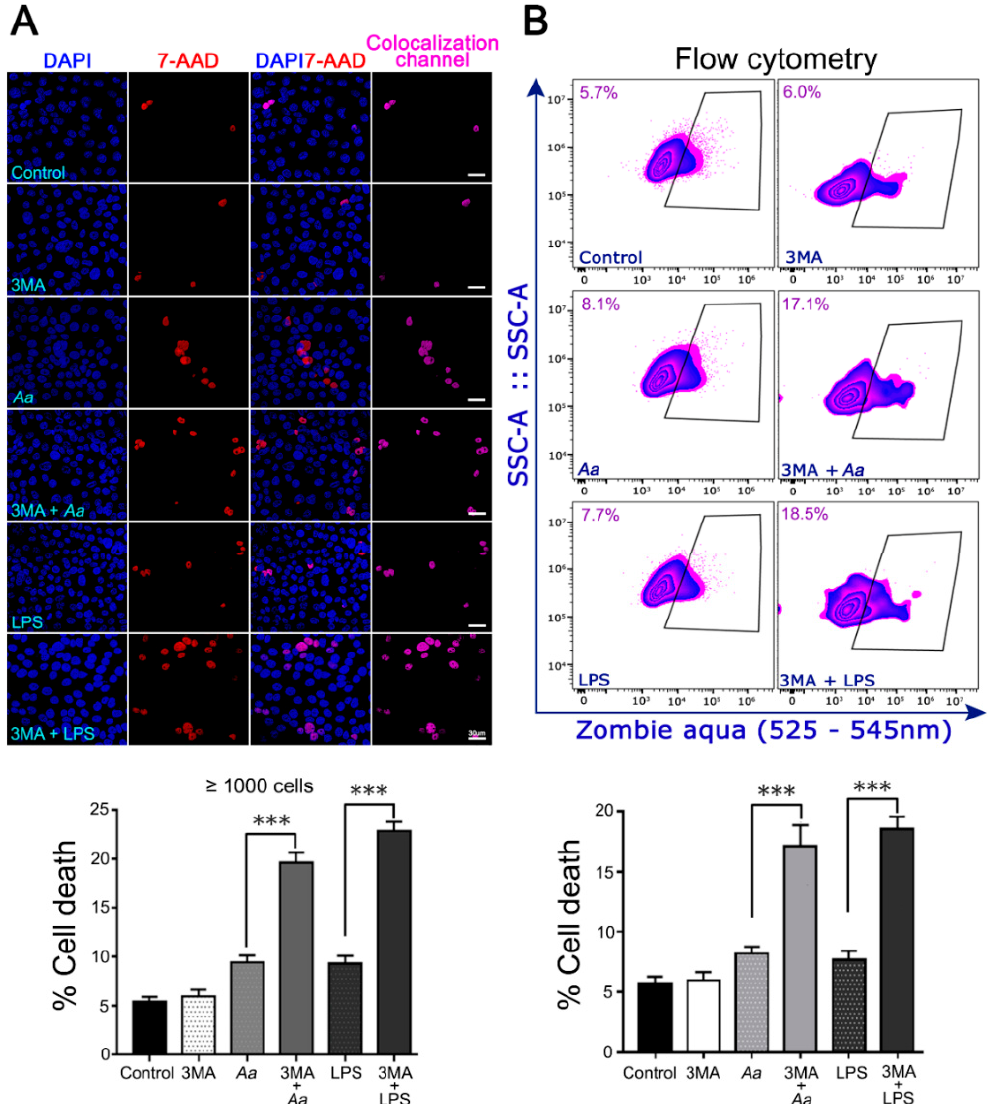
Figure 8. Impact of autophagy pharmacological inhibition on host-cell viability after A. actinomycetemcomitans ( A.a ) challenge. OKF6 / TERT-2 cells were incubated with A.a or its purified LPS in the presence or not of 3-MA, an upstream autophagy inhibitor. ( A ) Fluorescence staining visualized by confocal microscopy. After bacterial infection or LPS-stimulation OKF6 / TERT-2 cells were washed and incubated with the fluorescent nucleic acid dye 7-aminoactinomycin (7-AAD). Cells were fixed and stained with the fluorescent dye DAPI and analyzed by confocal microscopy. Blue: DNA-rich structures stained with DAPI (total cell population). Red: DNA-rich structures stained with 7-AAD (dead cells). DAPI / 7-AAD: overlap of images obtained from DAPI and 7-AAD channels. Colocalization channel: cells labeled by both fluorophores. The bar graph represents the percentage of dead cells (7-AAD positive) recorded in 1000 cells of three independent experiments. ( B ) A.a -infected or LPS-stimulated OKF6-TERT-2 cells were washed and incubated with the amine-reactive fluorescent dye Zombie Aqua and analyzed by flow cytometry. Dot-plots represent the total acquired events showing the live and dead (inside the black box) cell populations. The bar graph below represents the percentage of cell death obtained by flow cytometry of five independent assays. *** p <